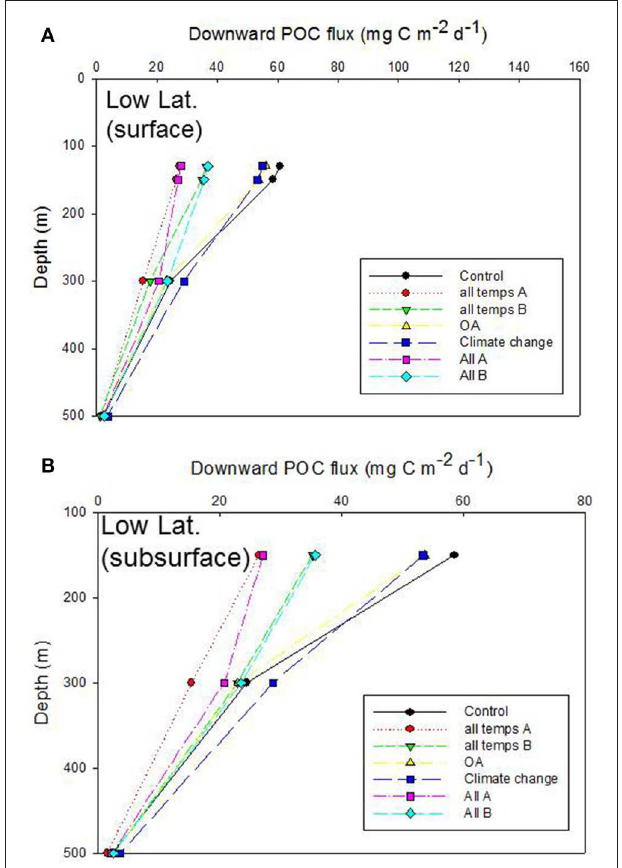
FIGURE 7 | Vertical profile of projected POC flux for the control run, low latitude case. The additional simulations in (A,B) are as described in Figures 6A,B